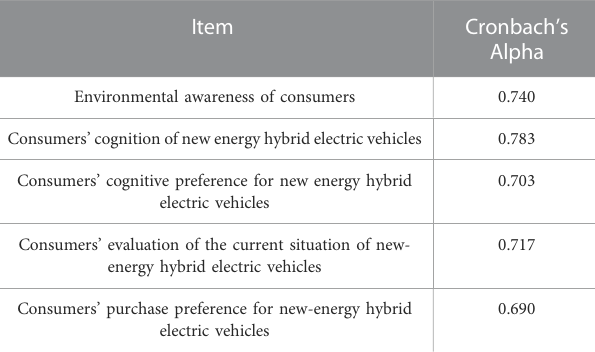
TABLE 5 Reliability test of the